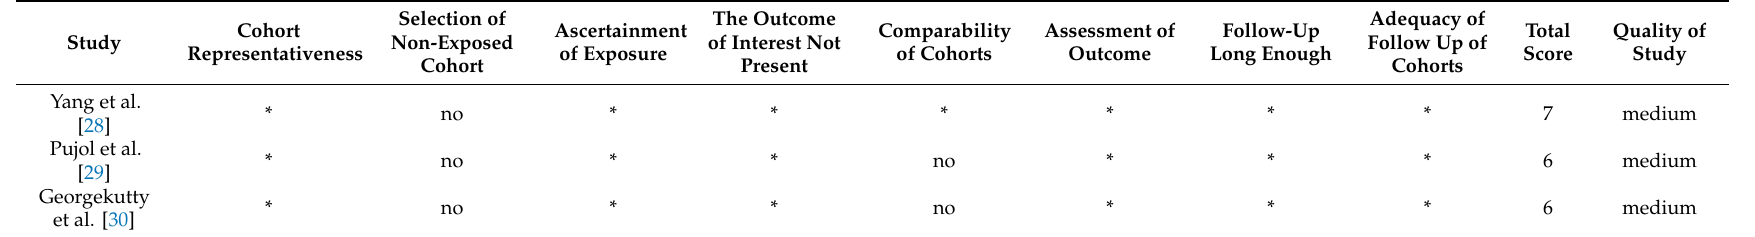
anticoagulants. Table 2. Quality assessment using the Newcastle-Ottawa